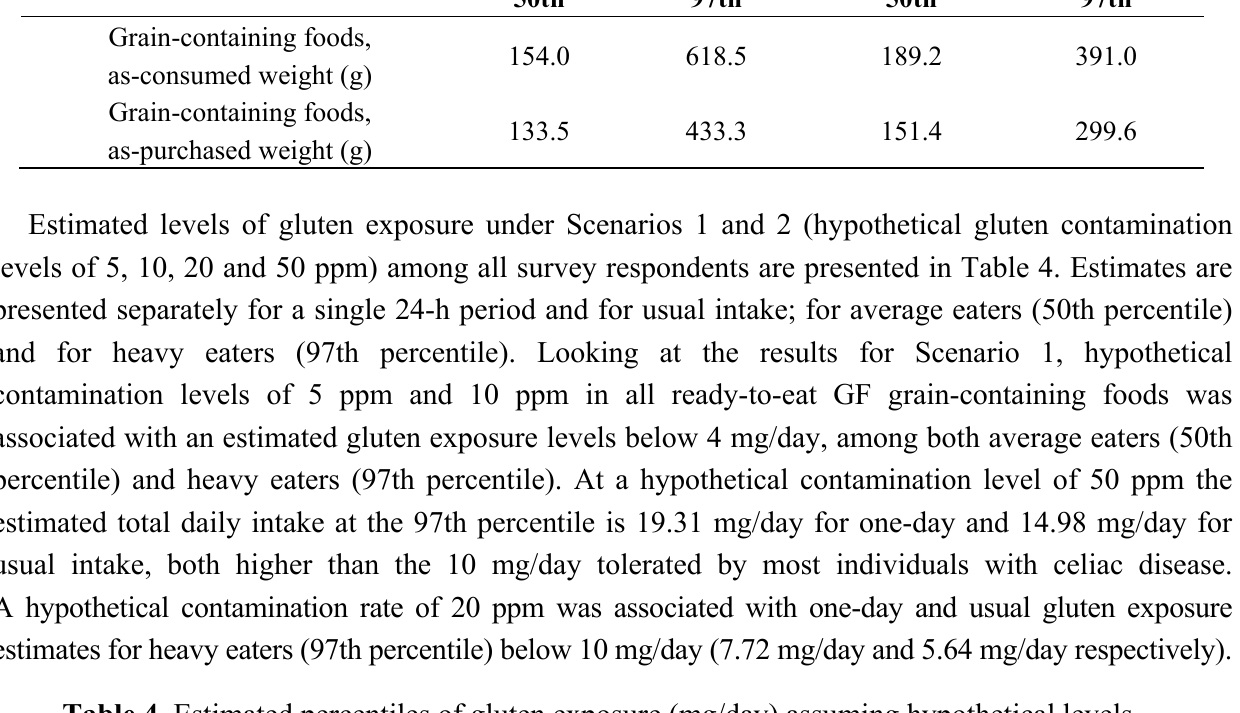
Table 4. Estimated percentiles of gluten exposure (mg/day) assuming hypothetical levels of gluten contamination of 5, 10, 20 or 50 ppm in as-purchased